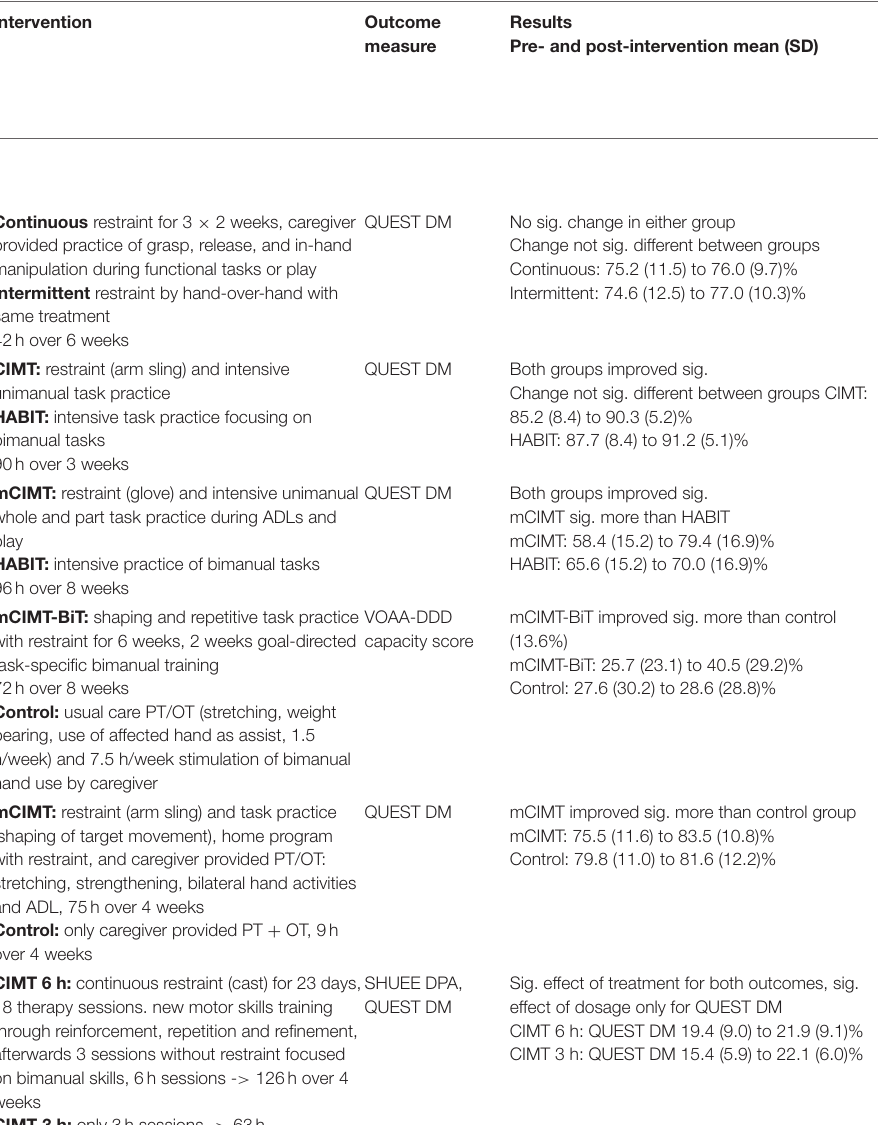
TABLE 1 | Overview of the included